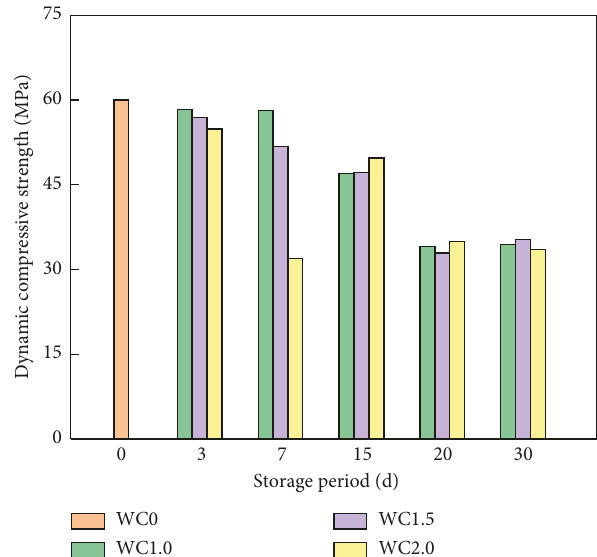
Figure 8: Dynamic compressive strength for ready-mixed concrete with 0.9MPa impact pressure in passive confining pressure